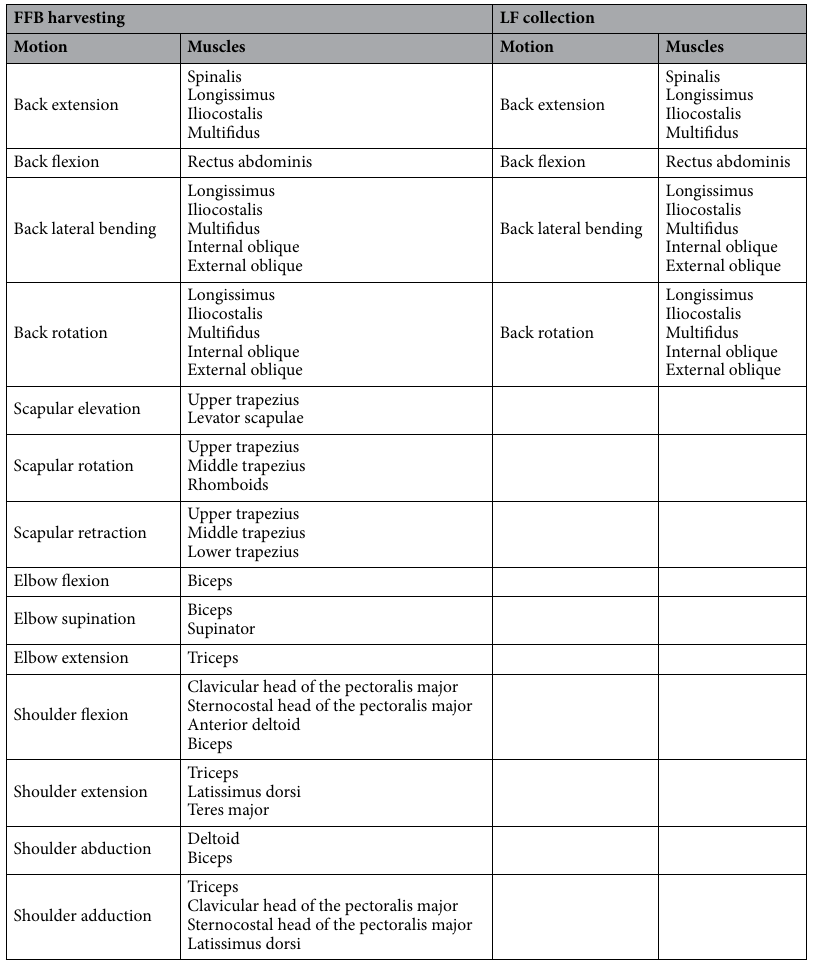
Table 1. Fundamental motions and muscles involved during FFB harvesting and LF collection 30, 31 .